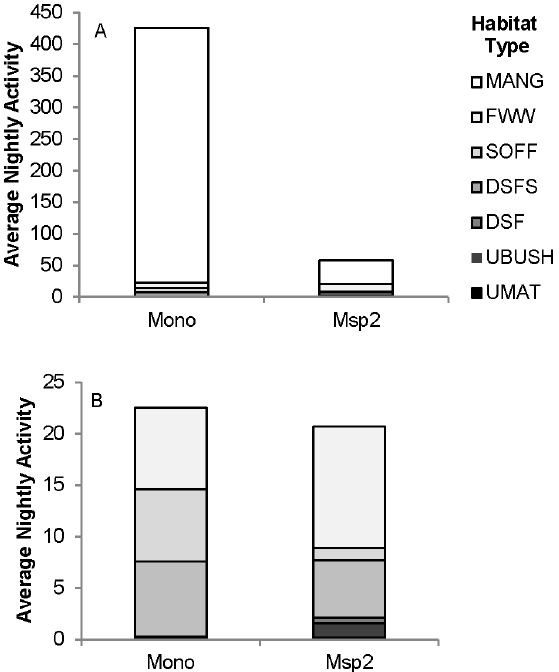
Figure 2. Average nightly bat activity. Average nightly bat activity (number of passes) recorded for each species in the study area across a) all seven landscape categories and b) landscape categories excluding mangrove forest. Abbreviations are: Mormopterus norfolkensis (Mono); M. species 2 (Msp2); FWW - freshwater wetland; DSF - dry sclerophyll forest and woodland; DSFS - dry sclerophyll forest and woodland on sand; UBUSH - urban bushland remnant; UMAT - urban matrix; MAN - mangrove forest; and SOFF - swamp oak